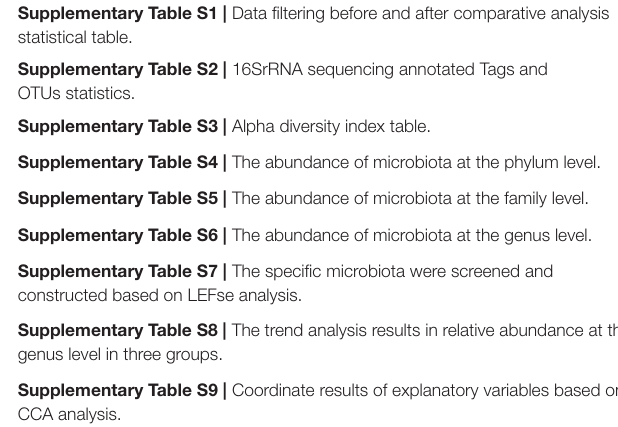
Supplementary Figure S4 | Gene trend diagram. Supplementary Table S1 | Data filtering before and after comparative analysis statistical table. Supplementary Table S2 | 16SrRNA sequencing annotated Tags and OTUs statistics. Supplementary Table S3 | Alpha diversity index table. Supplementary Table S4 | The abundance of microbiota at the phylum level. Supplementary Table S5 | The abundance of microbiota at the family level. Supplementary Table S6 | The abundance of microbiota at the genus level. Supplementary Table S7 | The specific microbiota were screened and constructed based on LEFse analysis. Supplementary Table S8 | The trend analysis results in relative abundance at the genus level in three groups. Supplementary Table S9 | Coordinate results of explanatory variables based on CCA